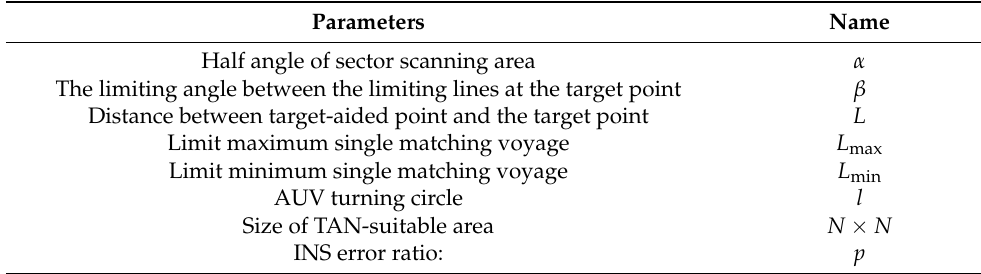
Table 2. Parameter